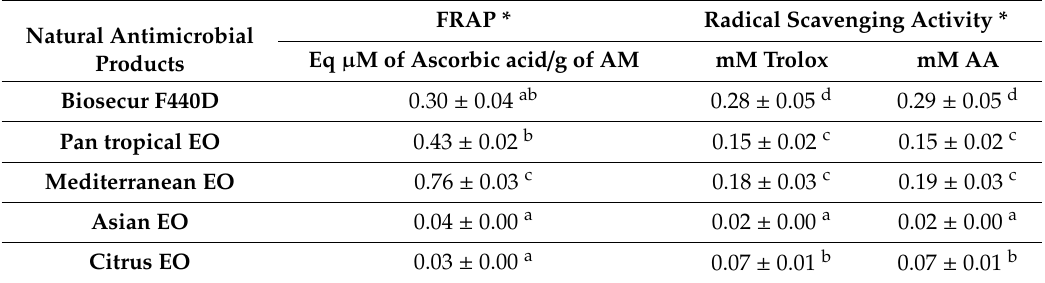
Ferric reducing antioxidant power (FRAP) and Radical Scavenging Activity of the antimicrobial